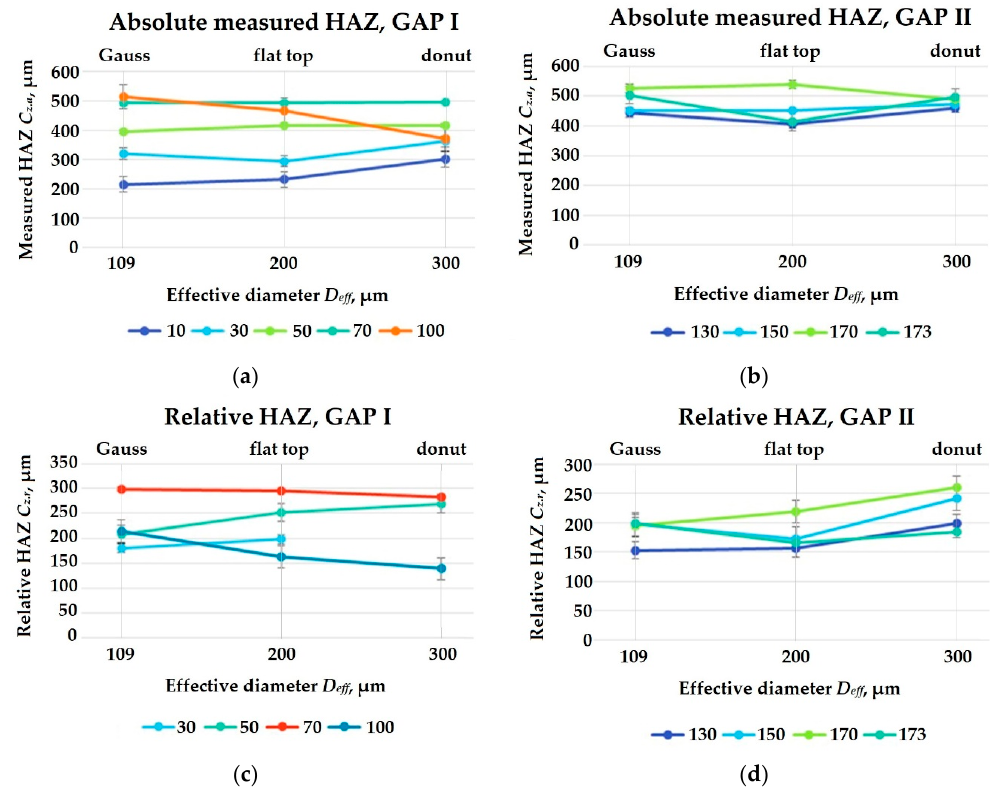
Figure 16. Dependence of average values of heat-affected zone (HAZ) on effective diameter for different values of laser power: ( a ) absolute value of HAZ for I technological gap for V s = 0.005 ÷ 0.05 m/s; ( b ) absolute value of HAZ for II technological gap for V s = 0.04 ÷ 0.1 m/s; ( c ) relative value of HAZ for I technological gap V s = 0.005 ÷ 0.05 m/s; ( d ) relative value of HAZ for II technological gap V s = 0.04 ÷ 0.1